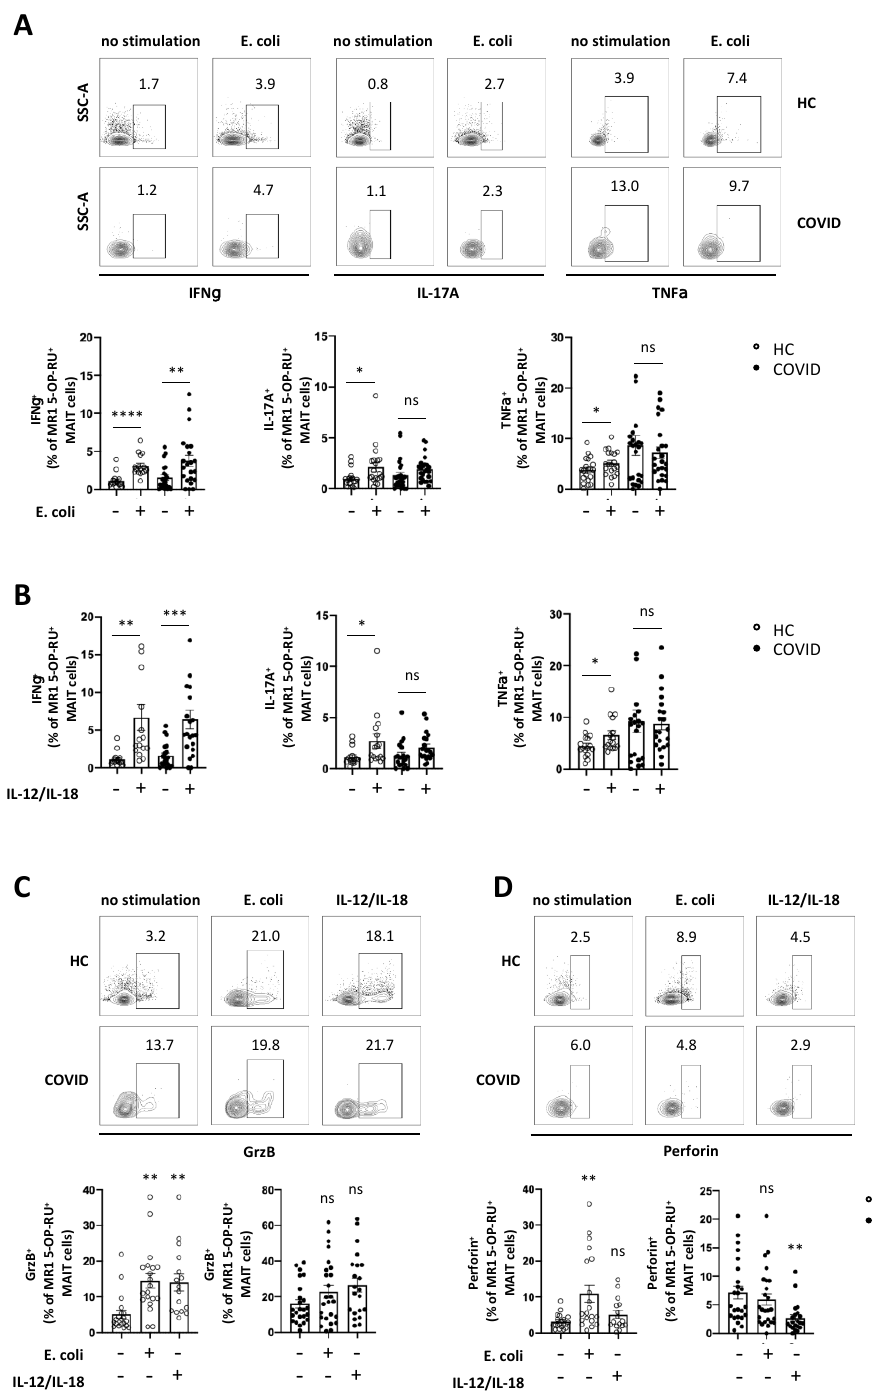
Figure 4. MAIT cells from peripheral blood of COVID-19 patients show an altered cytokine expression profile. Intracellular cytokine expression in MAIT cells in a PBMC pool from peripheral blood of COVID-19 patients and healthy controls (HC) following co-culture with E. coli at 10 bacteria per cell ( A , C , D ) or stimulation with 50 ng/mL IL-12/IL-18 ( B , C , D ) for 24 h. Data are presented as mean ± SEM and were pooled from three independent experiments; each symbol represents one patient. ( A ) IFN γ : HC n = 16 and COVID n = 22; IL-17A/TNF α : HC n = 20 and COVID n = 24; ( B ) IFN γ : HC n = 16 and COVID n = 21; IL-17A/TNF α : HC n = 26 and COVID n = 20; ( C , D ) HC n = 16 and COVID n = 21; * p < 0.05 and ** p < 0.01 vs. unstimulated control. Data were assessed using paired t-test ( A , B ) or one-way analysis of variance (ANOVA) with Dunnett’s multiple comparisons test ( C , D ). ns = not significant.